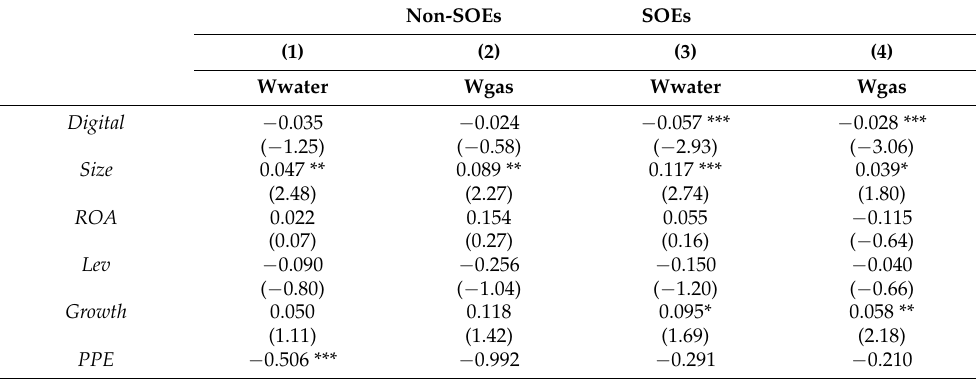
Table 6. Cross-section analysis: firms’ ownership structure. This table reports the results of OLS regressions examining the effect of digital transformation on environmental pollution. In columns 1–4, we split the samples into SOE and non-SOE groups. Appendix A provides definitions of variables. The regressions control for a year and industry fixed effects. In parentheses are t -statistics based on standard errors adjusted for heteroskedasticity and firm